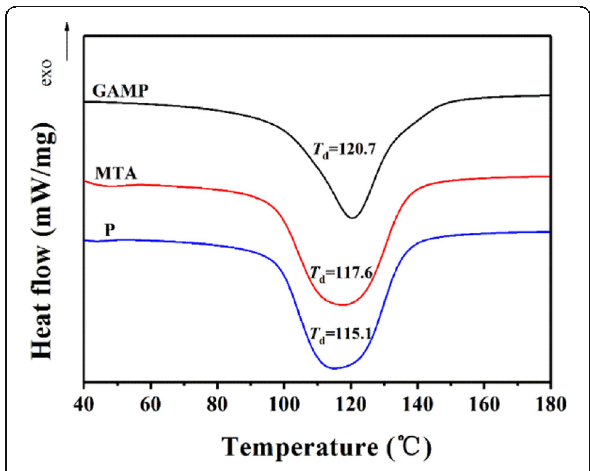
Fig. 6 DSC thermogram of leather samples retanned with the different retanning